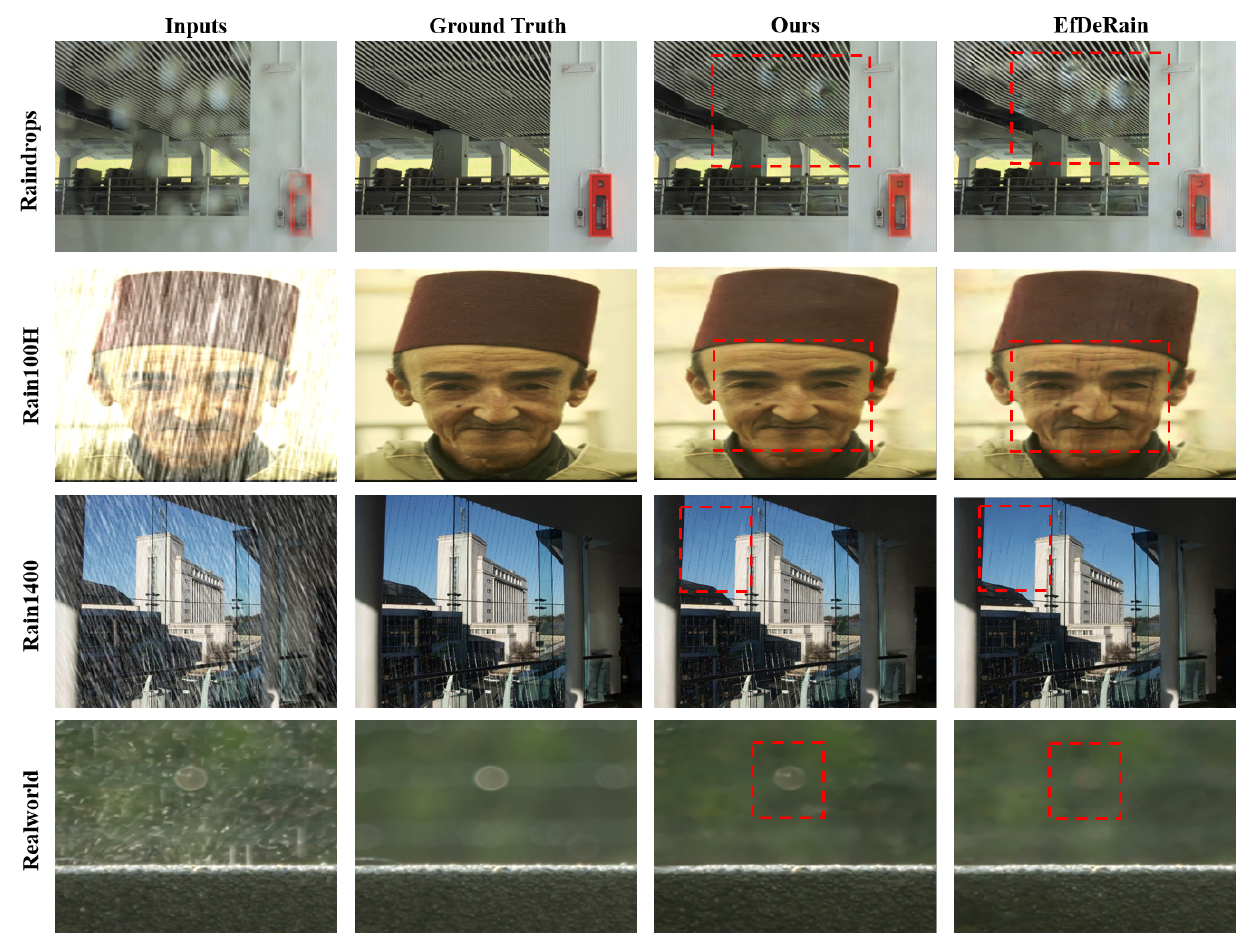
Figure 9. The visualisation comparison on Raindrops, Rain100H, Realworld, and Rain1400. DAMNet performs better than EfDeRain in terms of removing rain streaks and preventing side effects.